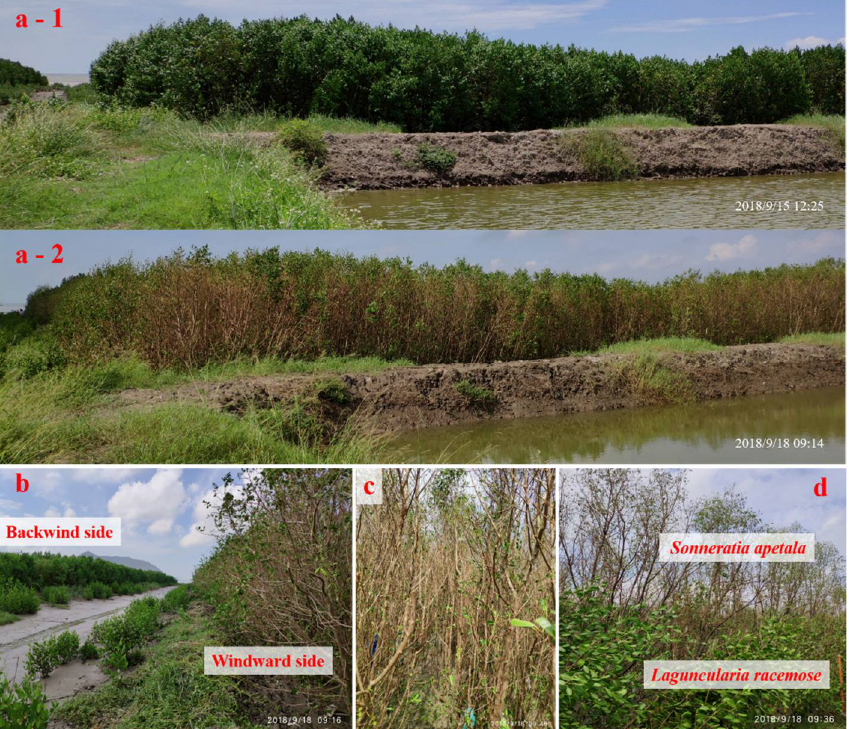
Figure 6. Photography showing severe mangrove defoliation due to typhoon Mangkhut, with the locations and shooting angles shown in Figure 5. ( a-1 ) and ( a-2 ) shows the mangrove trees before and after typhoon impact at the shoreside edge along the wind path. ( b ) compares the severely defoliated trees along the windward side and the intact trees along the backwind side of a tidal channel. ( c ) shows severe defoliation at the middle of the windward side edge. ( d ) shows greater defoliation in the taller Sonneratia apetale and less defoliation in the shorter Laguncularia racemosa within the same location.